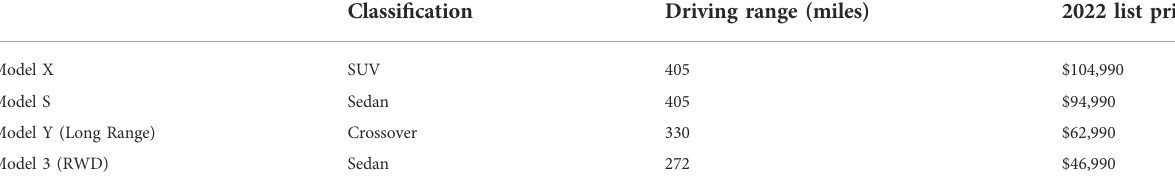
TABLE 5 Comparison of Tesla ’ s four products (Supercars.net,